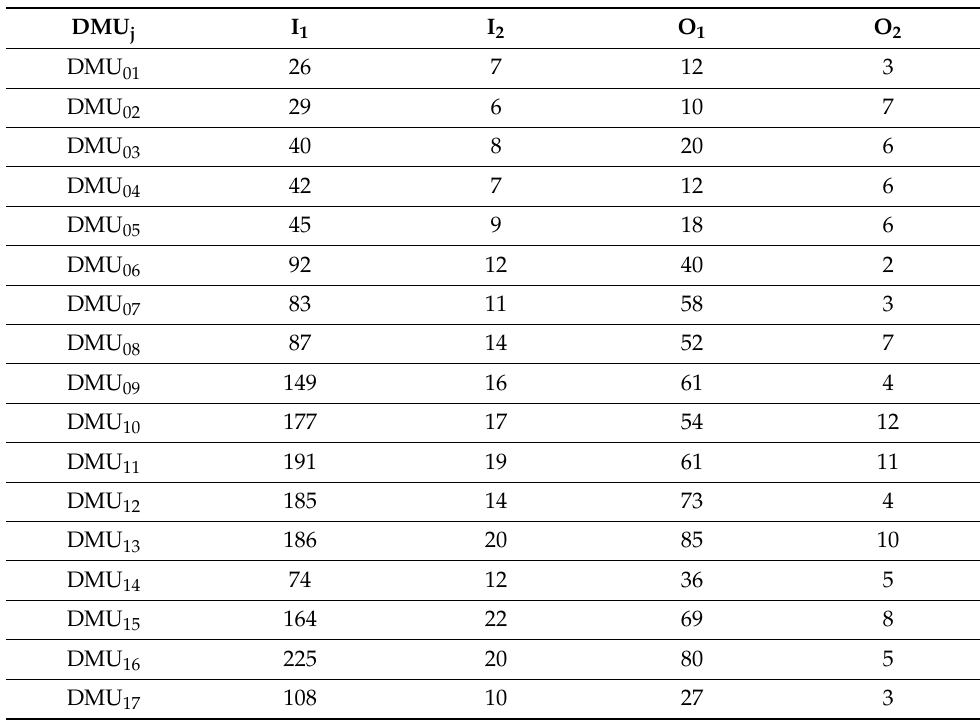
Table 2. Data of the first case study.